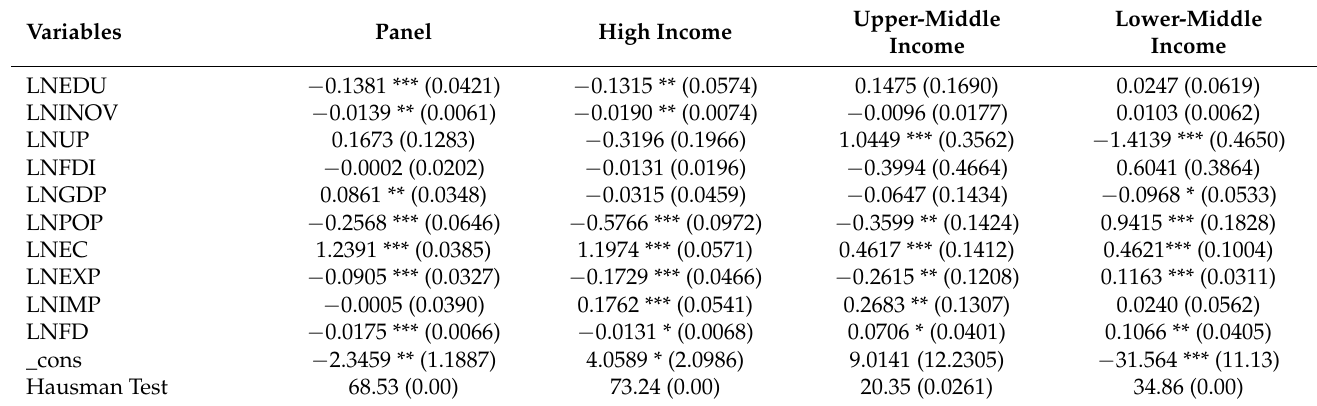
Table 7. Robustness Test Results for Panel and Different Income Groups.